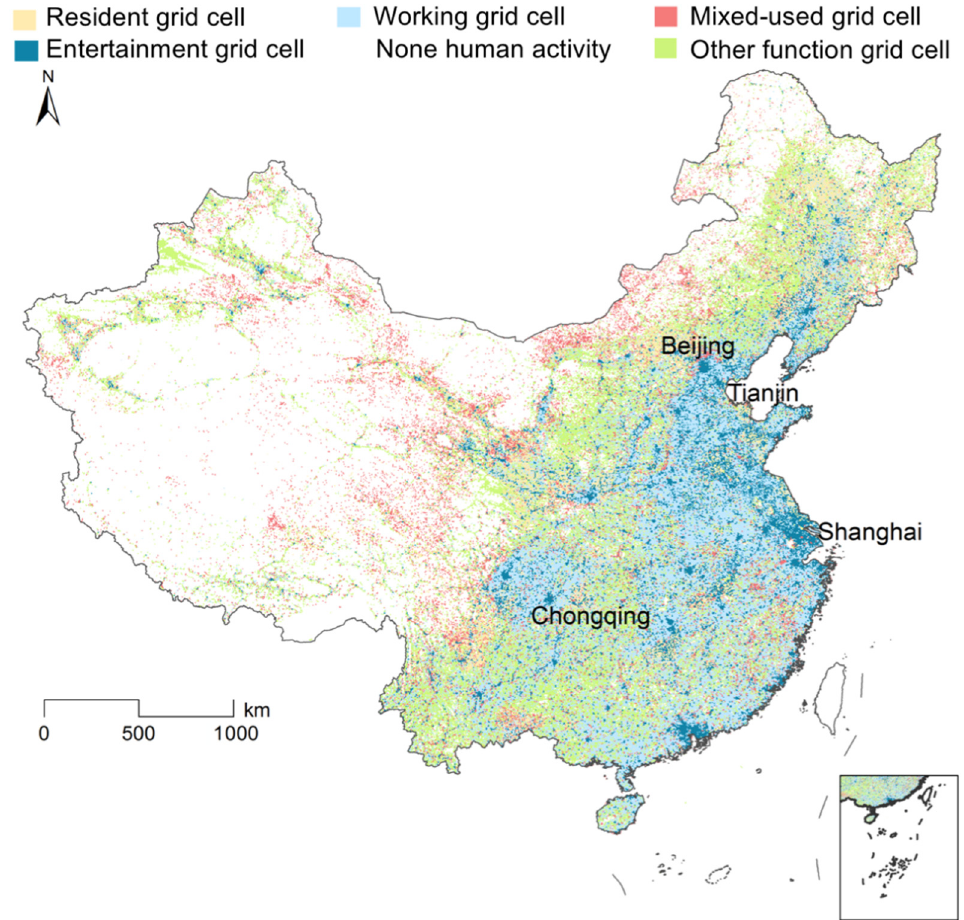
Figure 3. The spatial distribution of land use categories across China Mainland.